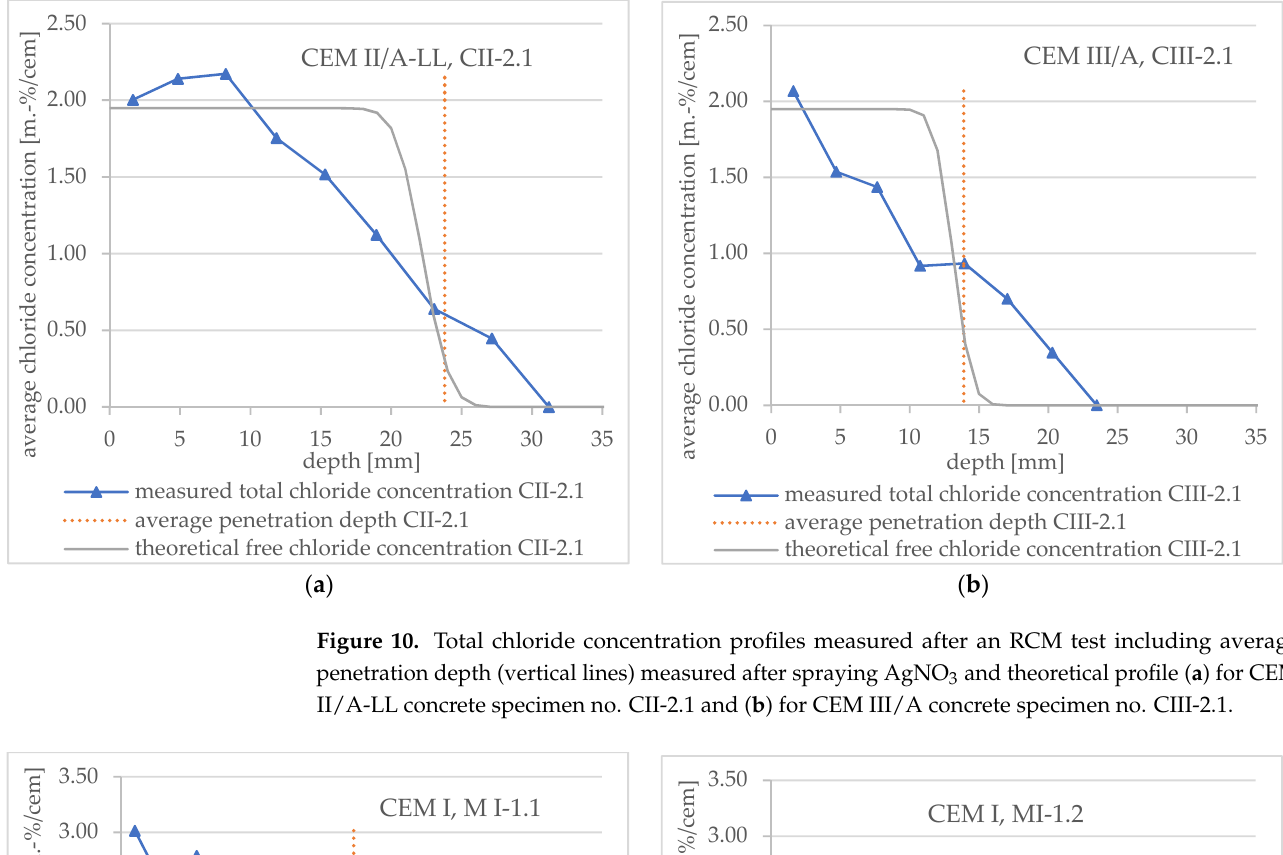
Figure 10. Total chloride concentration pro fi les measured after an RCM test including average penetration depth (vertical lines) measured after spraying AgNO 3 and theoretical pro fi le ( a ) for CEM II/A-LL concrete specimen no. CII-2.1 and ( b ) for CEM III/A concrete specimen no. CIII-2.1. The comparison shows that the measured pro fi les for both binders di ff er signi fi cantly from Tang’s theoretical pro fi le. In the literature, similar results can be found [7–9,22] (see also Section 1). A consideration and discussion of the chloride concentration at color change boundary can be found in Section 3.4.3.